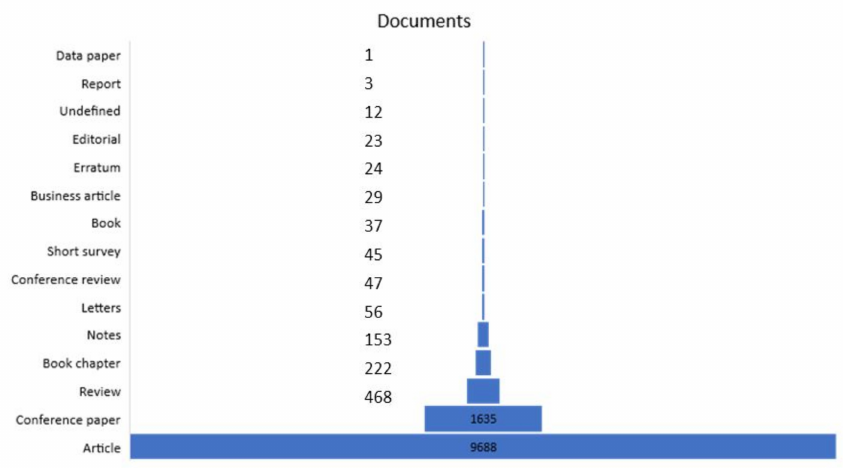
Figure 16. Representation of the type of documents published in Scopus about